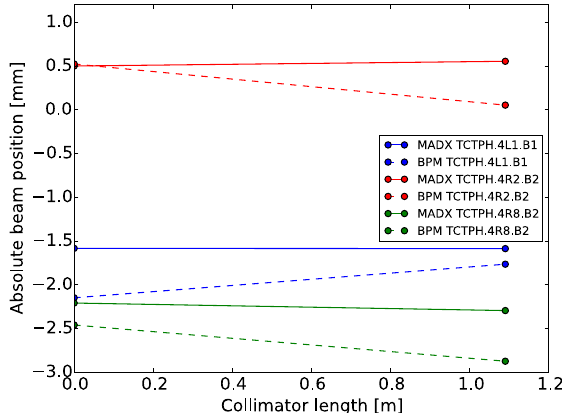
FIG. 7. A comparison of the absolute beam centers measured using the BLM-based and BPM-based techniques, and the differences between the average of the upstream and downstream BPM-based positions and the BLM-based positions, at injection and flat top.